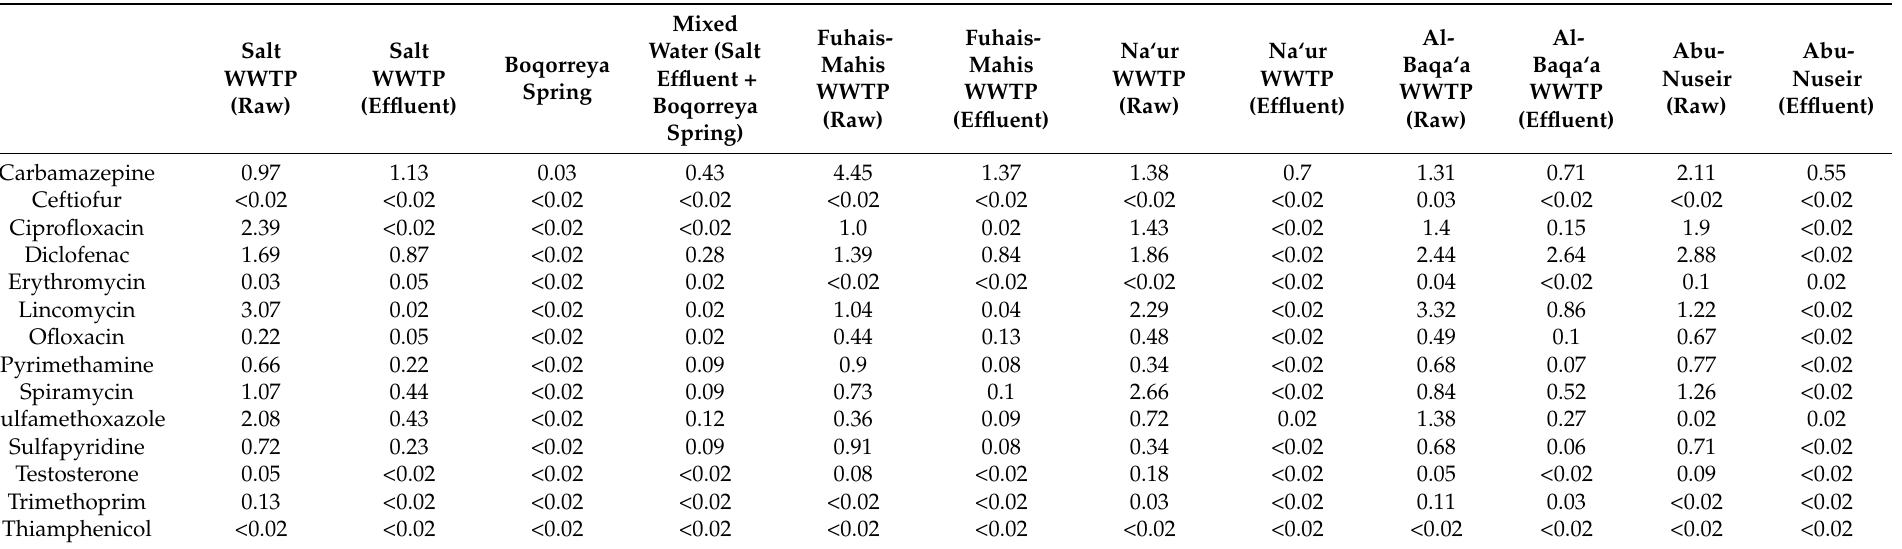
Table 5. Concentration of PPCPs in various WWTP water samples, Boqorreya spring, and mixing point of Salt WWTP effluents with Boqorreya Spring water in ( µ